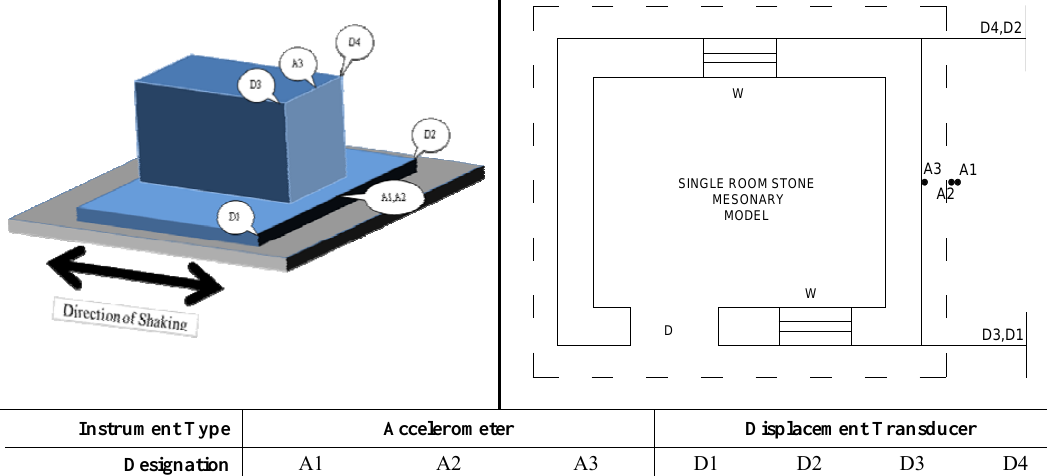
Figure 4 Testing setup and instrumentation details of the building model tested on shake table at the Earthquake Engineering Center of Peshawar.